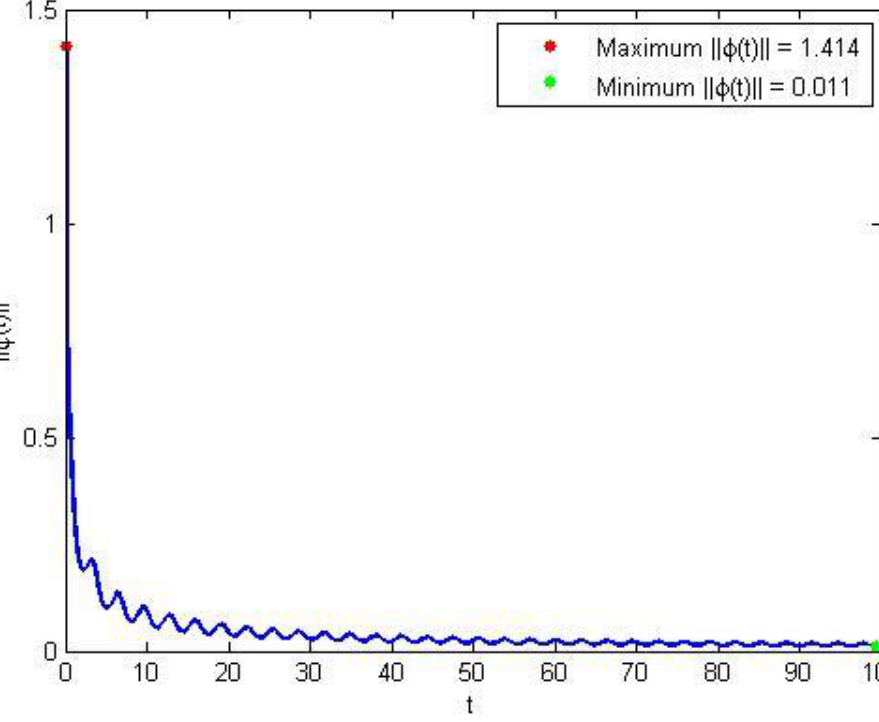
Figure 15. ‖𝑒(𝑡)‖ for system (10), with 𝛼 = 0.5 , 𝜌 = 0.5, and 𝑤(𝑡) = [2 𝑠𝑖𝑛(𝑡)] 𝑇 .